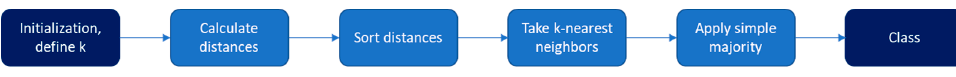
Figure 2. Indicative example of KNN steps.